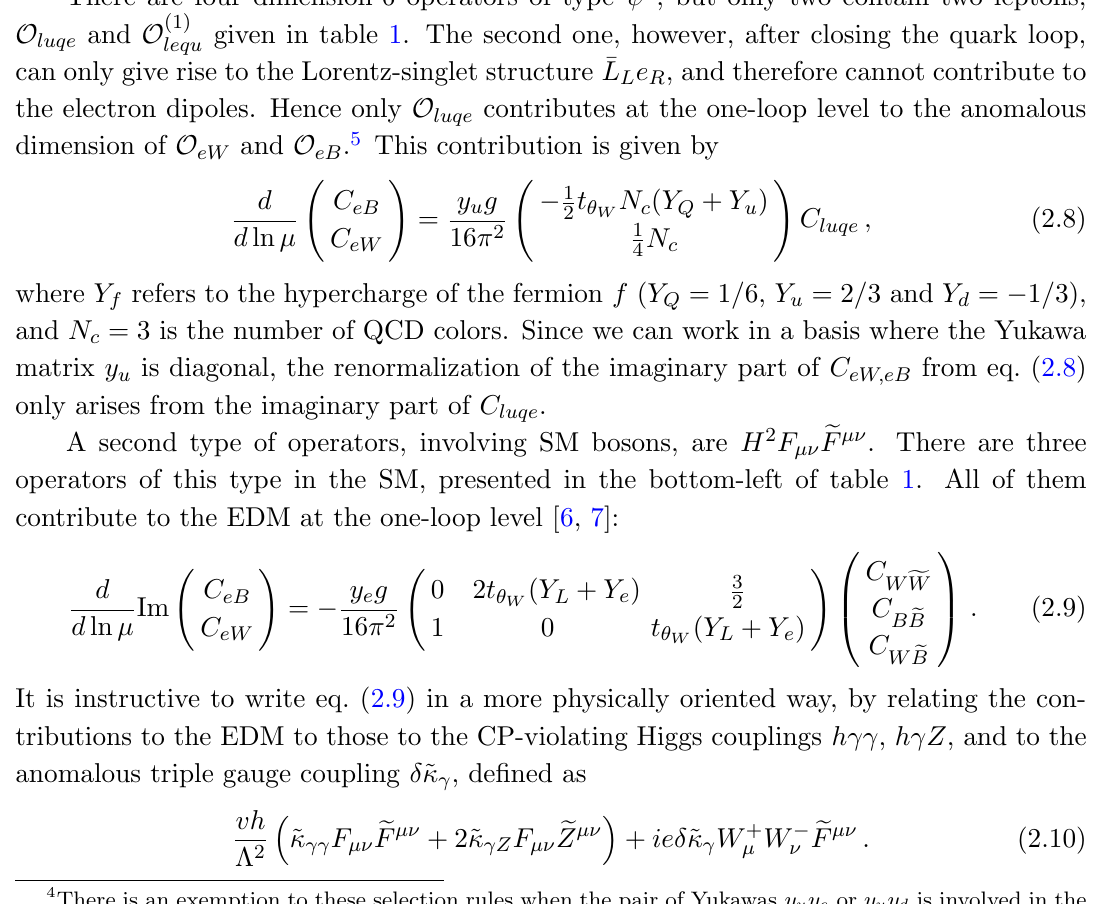
Table 2 . Selection rules [3, 4] for the mixing at the one-loop level between the di(cid:11)erent types of dimension-6 operators (in Weyl